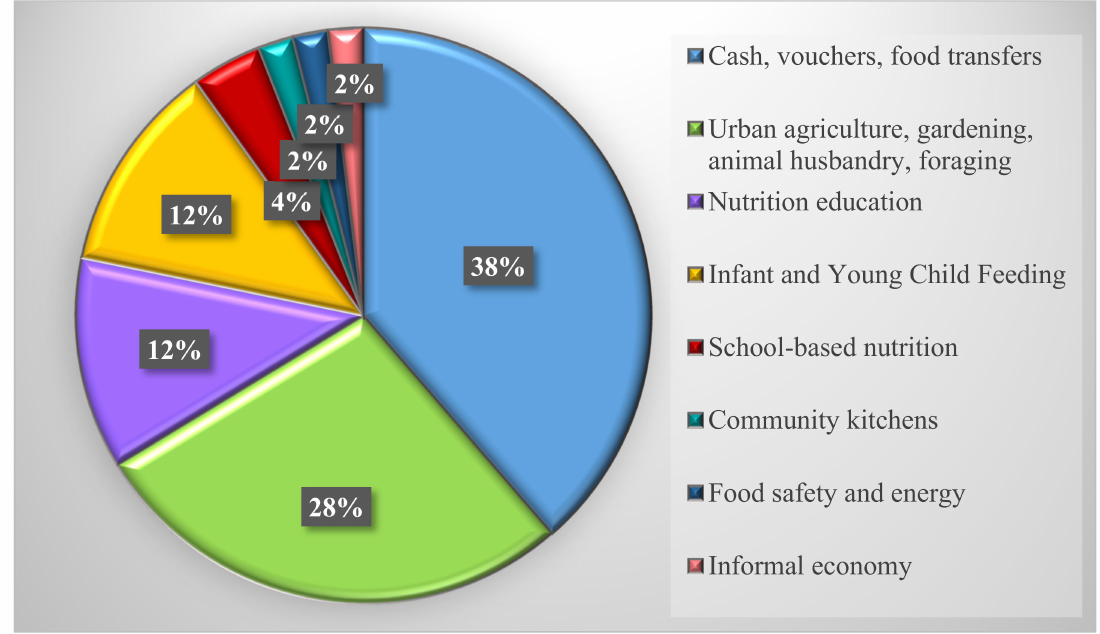
Figure 3. Percent of articles by intervention